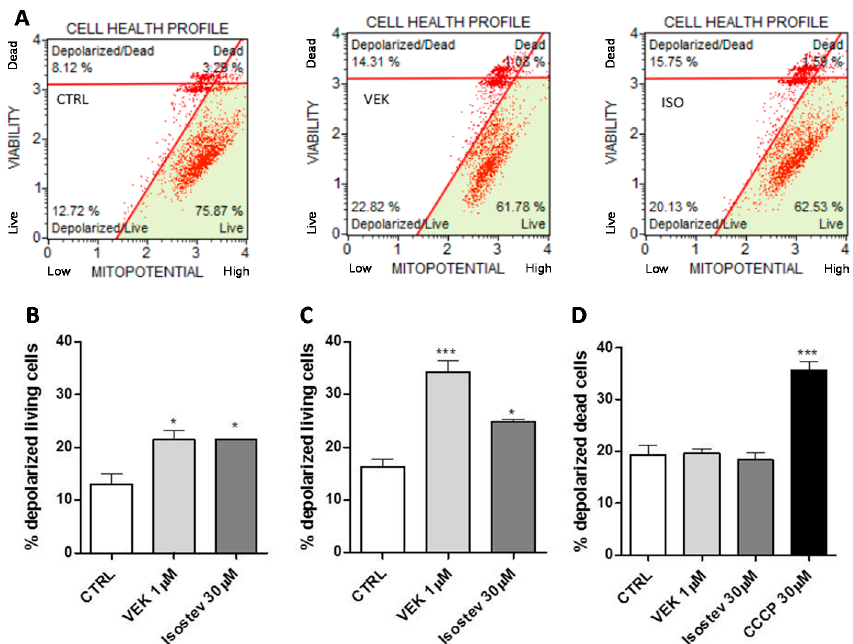
Figure 4. Change in mitochondrial Δ ψ related to compound 5 and isosteviol cell treatments. H9c2 cells were challenged with compound 5 , isosteviol, and CCCP for 2.5 and 5 h, then the mitochondrial Δ ψ was assessed by a cytofluorimetric technique. In panel ( A ), representative cytofluorimetric population profiles are reported (2.5 h challenge). The percentage of depolarized living cells after 2.5 and 5 h of drug treatments are shown in panels ( B , C ), respectively. The percentage of depolarized dead cells following 5 h ( D ) are also reported. Asterisks indicate significant differences vs. vehicle (* p < 0.05, *** p < 0.001).